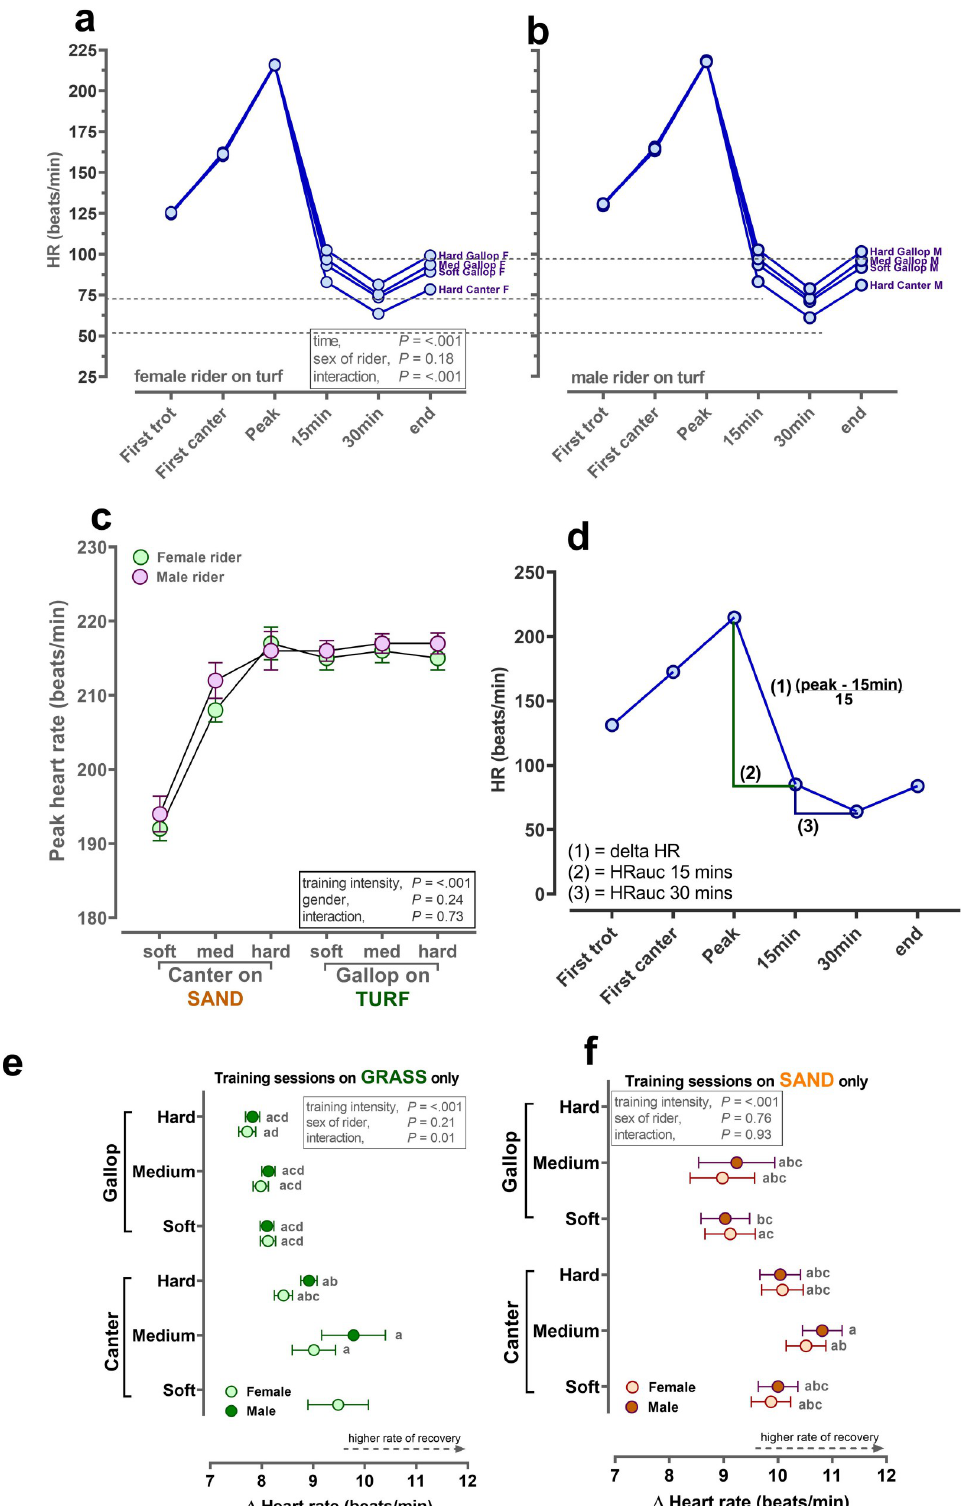
Fig 3. Racehorse heart rate on different track surfaces by sex of work rider. a,b,c,e,f: Values are predicted mean ± S.E. M. for continuous data recorded by ‘Equimetre’ in a cohort of racehorses in Australia (n = 130 different